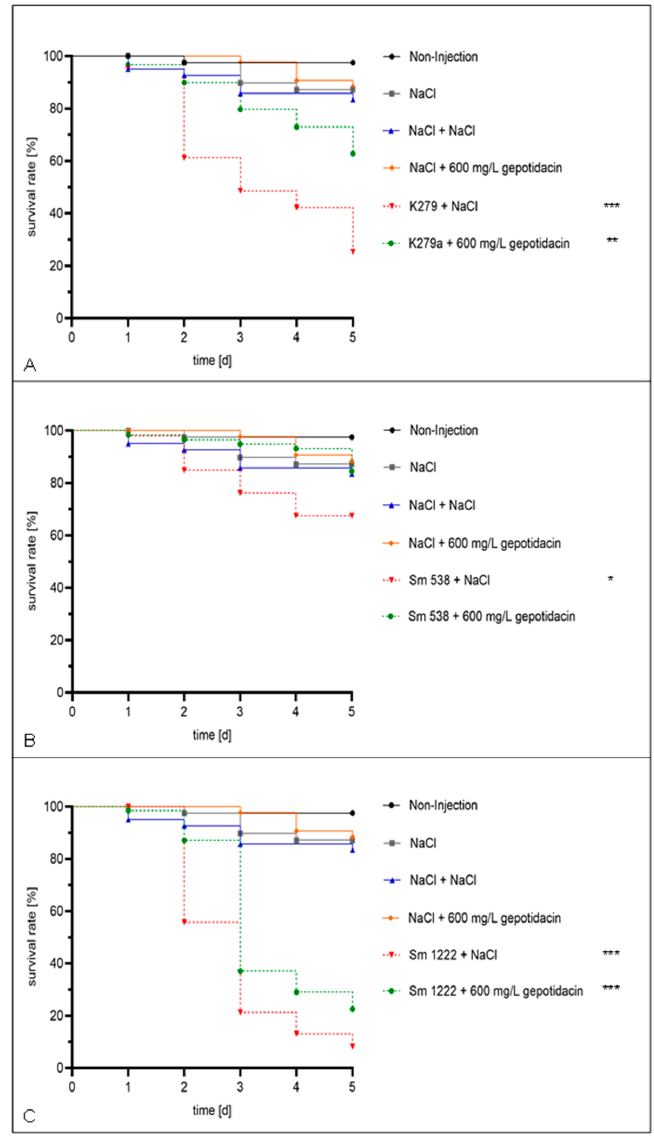
Figure 3. Single dose effect. The larvae were injected with a concentration of 10 5 cells/mL and treated after 4 h with NaCl or 600 mg/L gepotidacin, respectively. Double-treatment controls with double injection of NaCl or gepotidacin were set up. The larvae were followed-up for five days. Showing the survival rate of the larvae, which were infected with K279a ( A ), Sm 538 ( B ), and Sm 1222 ( C ). Significance levels are shown by asterisks: *: p < 0.05, **: p < 0.005, ***: p < 0.001 and were determined via logrank test using GraphPad Prism.